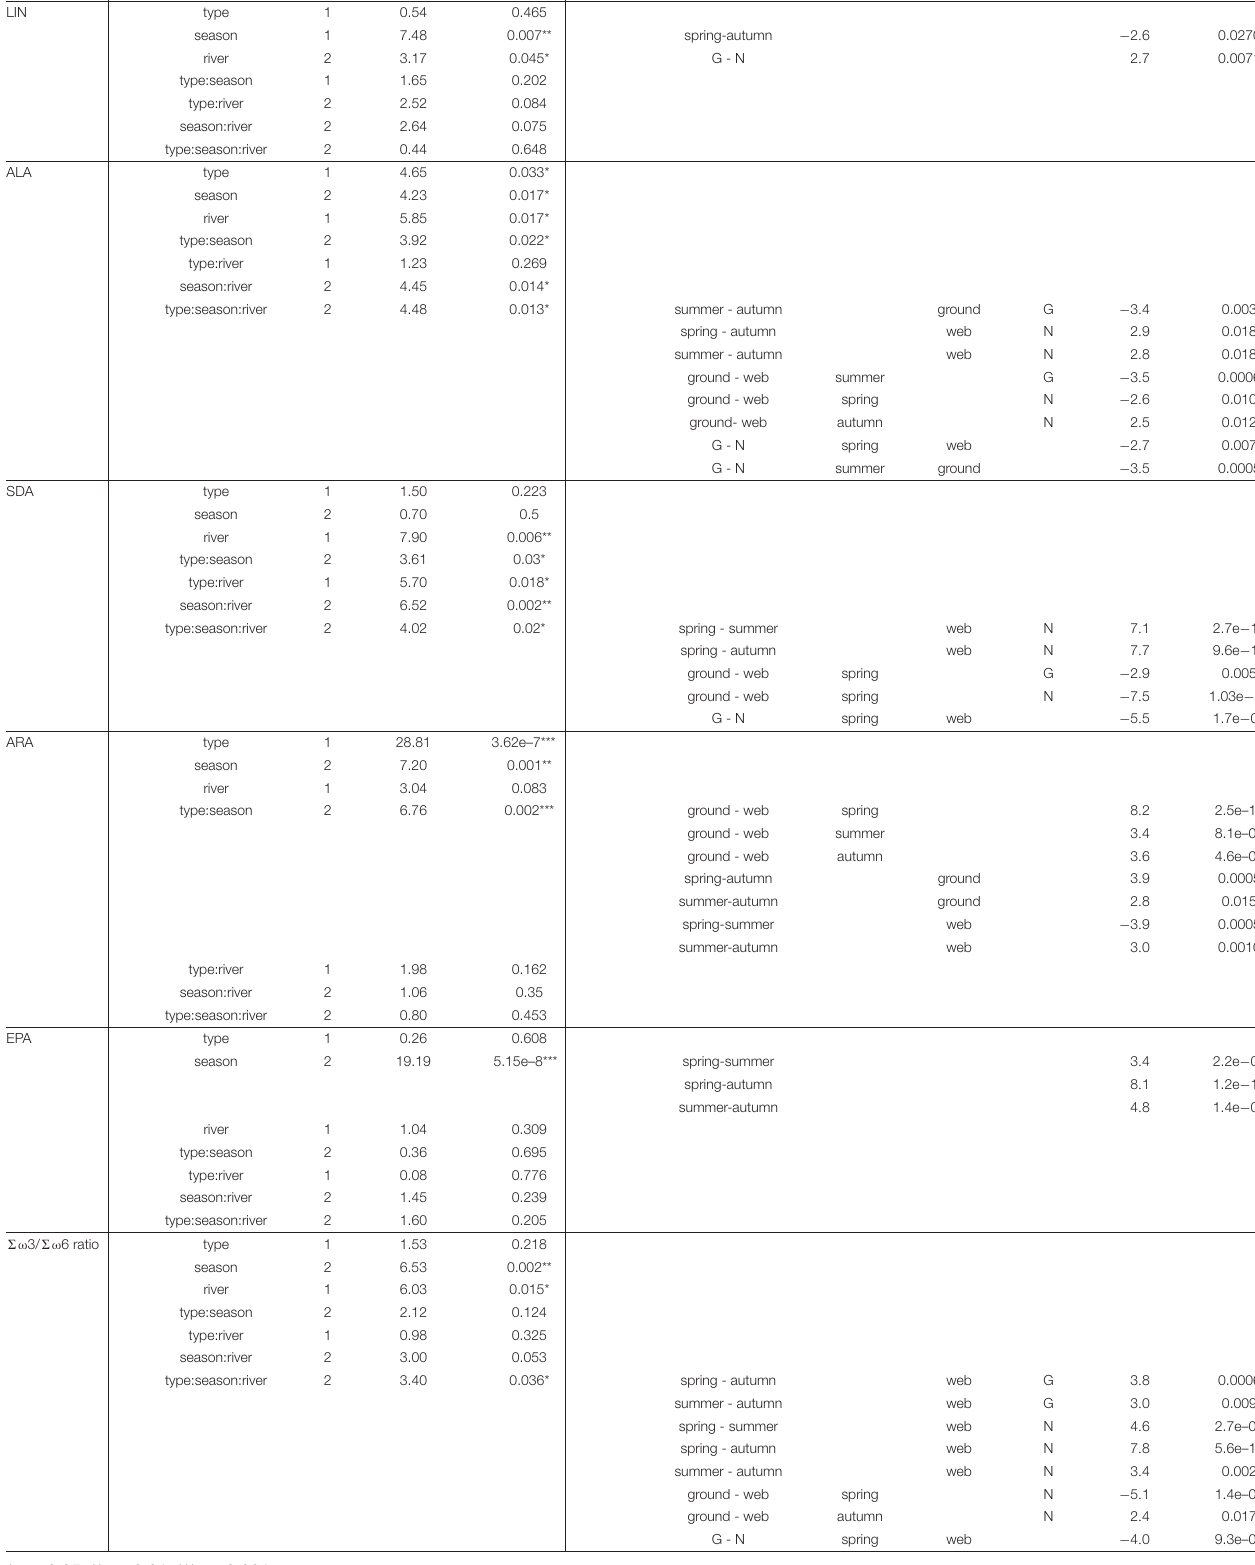
TABLE 2 | Factorial ANOVA of PUFA content in riparian spiders (factors: spider type = type, season, fluvial system = river) and significant post hoc comparisons (web, web spider; ground, ground spider; N, Necker; G, Glatt). Factor Df F -value Pr( > F) contrast season